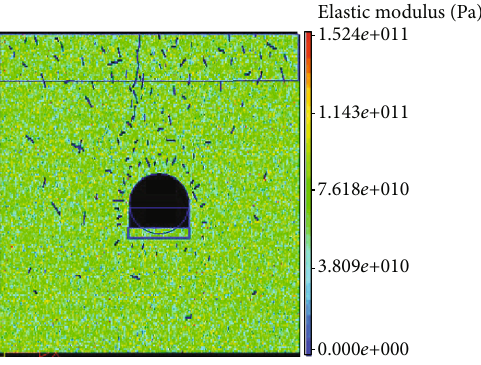
Figure 6: Calculation